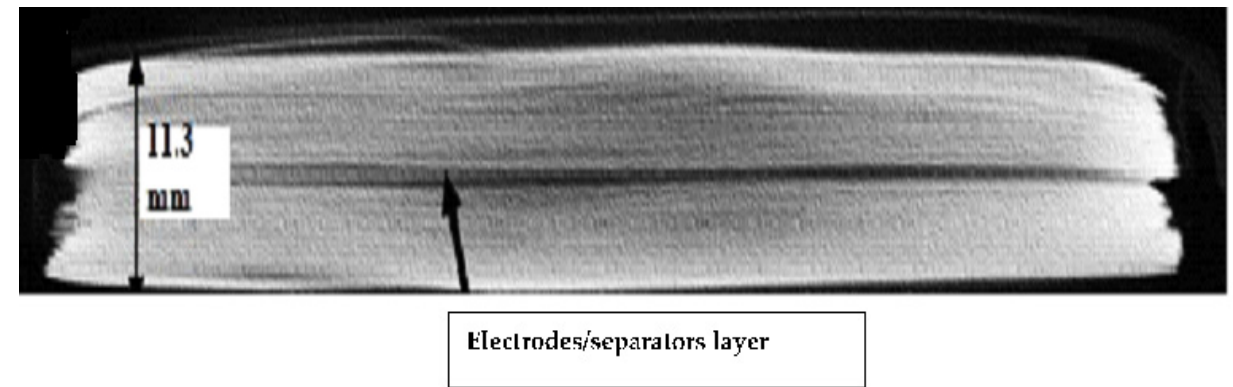
Figure 23. Interior of battery cells after opening the cover of a pouch cell, the first layer seen is a separator layer.